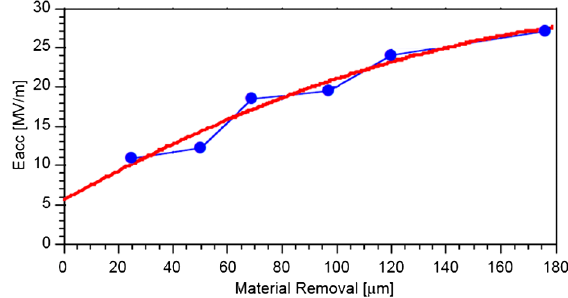
FIG. 1. Dependence of achievable gradients on the amount of material removed from the surface of a fine grain cavity